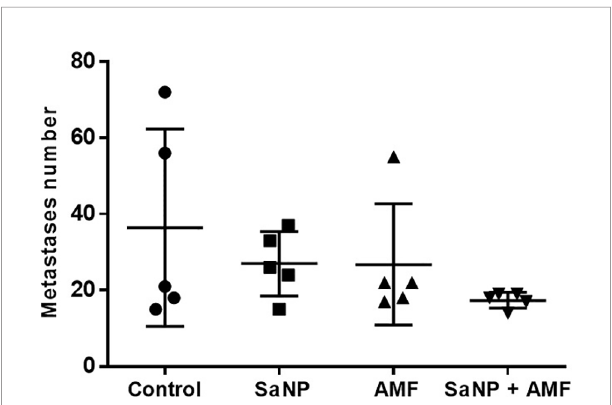
FIGURE 8 | Effect of treatment on the number of lung metastases in the 4T1 breast cancer model. Treatment cycles started at day 14 after cell inoculation. Mice were sacri fi ced on day 21 post treatment. The lungs were excised and the number of metastases was